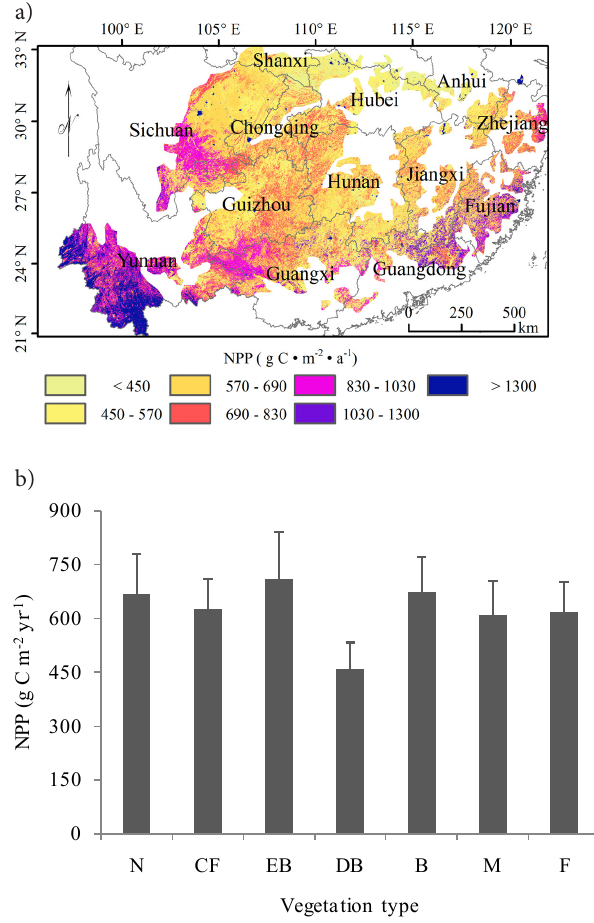
Figure 5. Spatial pattern of NPP in the study region. (a) spatial pat- tern of average NPP during study years, the intervals was chosen based on the quartile of cumulative distribution of the NPP; (b) the mean NPP of each vegetation type. Error bars represent standard de- viation within vegetation type. Abbreviations: N, coniferous forest; CF, Chinese fir; EB, evergreen broad-leaved forest; DB, deciduous broad-leaved forest; B, bush; F, farmland; M,